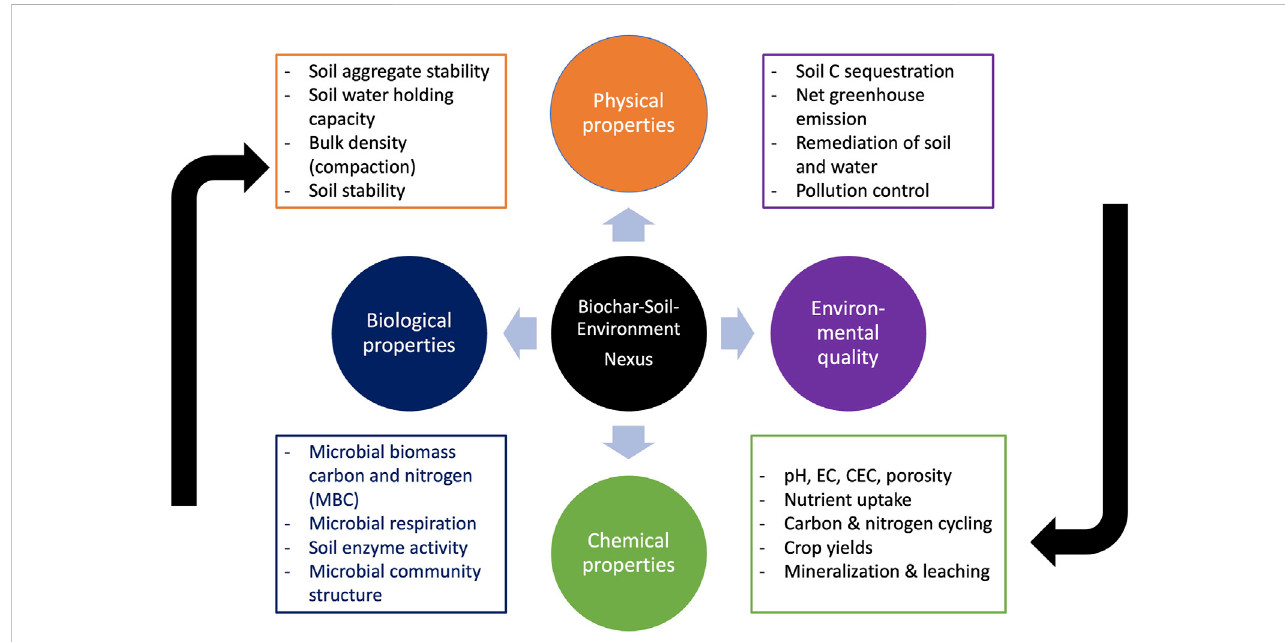
FIGURE 2 Biochar in soil physico-chemical properties (soil health) and environmental attributes (Biochar-Soil-Crop-Environment